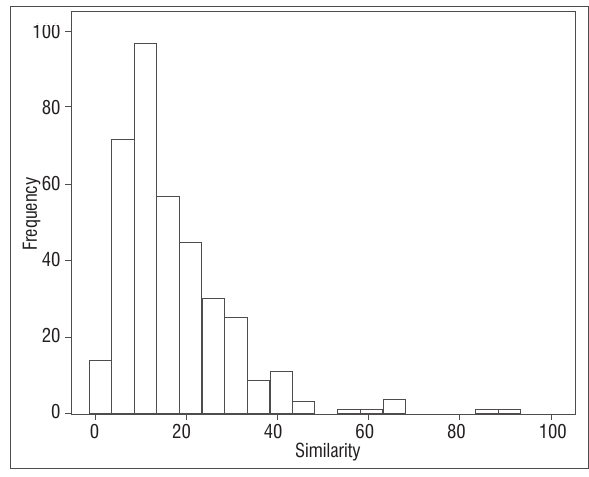
Figure 1: Distribution of the similarity index across 371